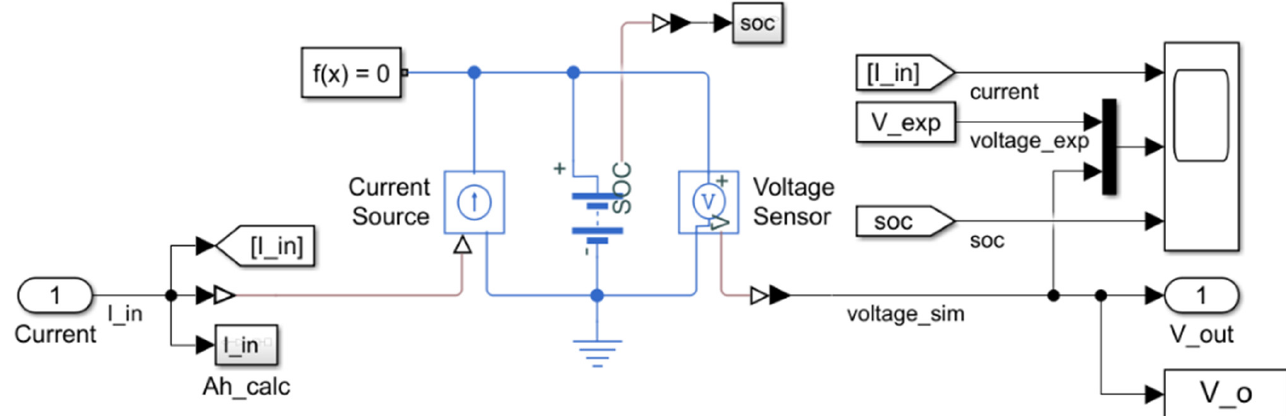
Figure 6. MATLAB model used for cell parameter estimation.